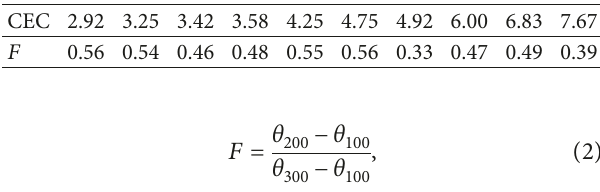
Table 2: Rheological model discriminant coefficient ( F